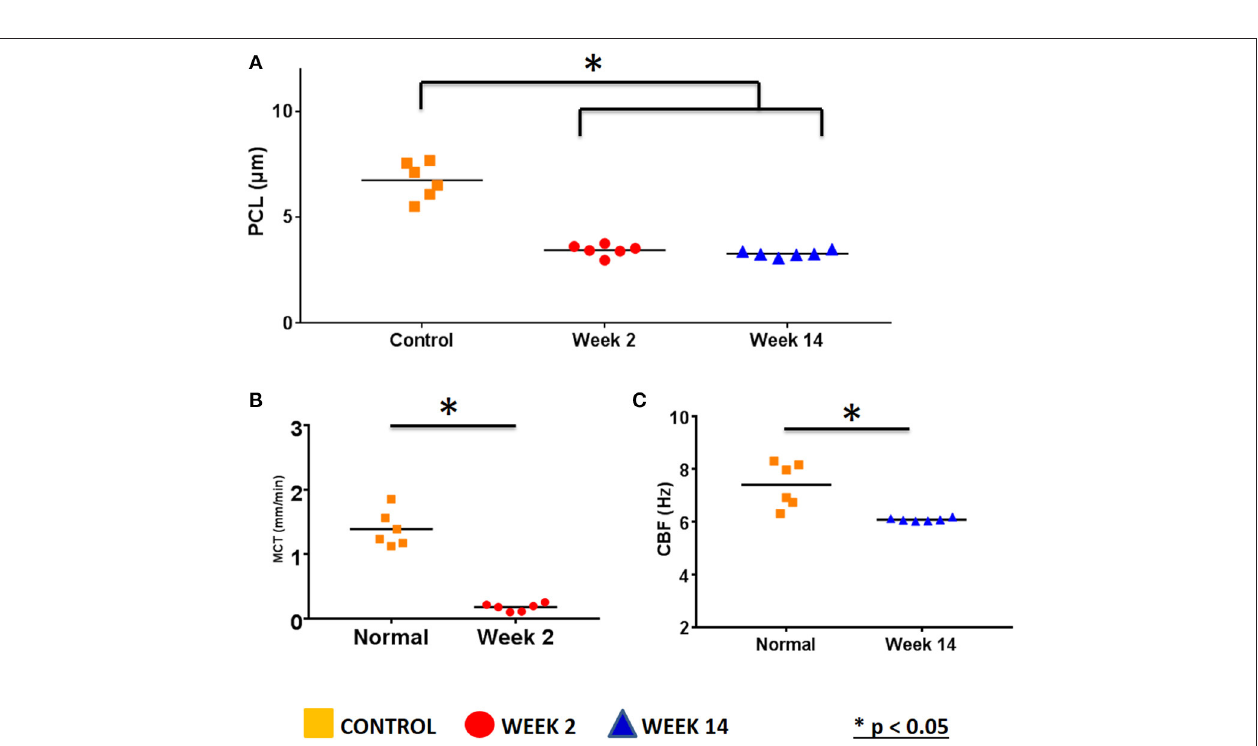
FIGURE 5 | µ OCT measurements of ex vivo sinus tissue. (A) ASL depth measured with µ OCT (Control = 6.74 ± 0.4 µ m, Week 2 = 3.45 ± 0.1 µ m, Week 14 = 3.27 ± 0.06 µ m, p < 0.0001). (B) MCT velocity measured with µ OCT (Control = 1.39 ± 0.11 mm/min, Week 2 = 0.18 ± 0.02 mm/min, p = 0.0044). (C) CBF measured with µ OCT (control = 7.4 ± 0.34Hz vs. Week 14 = 6.08 ± 0.02Hz, p < 0.0001) (* P <